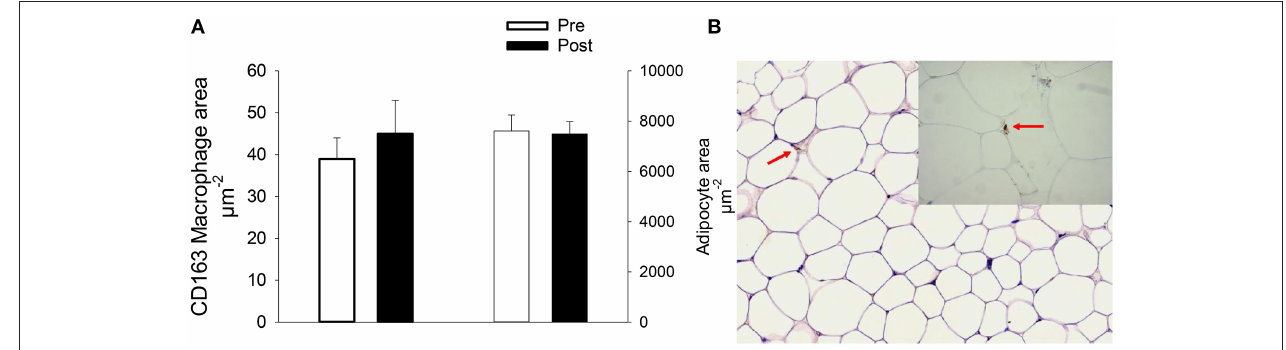
FIGURE 2 | CD163 macrophage content and adipocyte cell size in abdominal adipose tissue (A) and a representative picture of CD163 staining (Red arrows) in adipose tissue (B) in older male recreationally trained cyclist before and after 14 days repeated very prolonged exercise. The values are mean ±